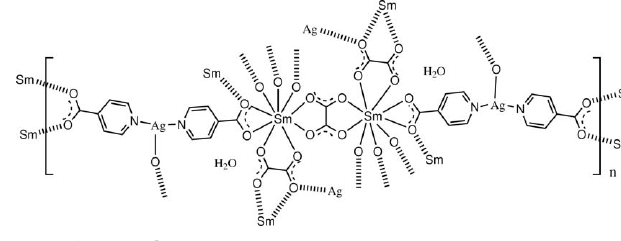
Bruker SMART APEX CCD- detector diffractometer Absorption correction: multi-scan ( SADABS ; Sheldrick, 2004)